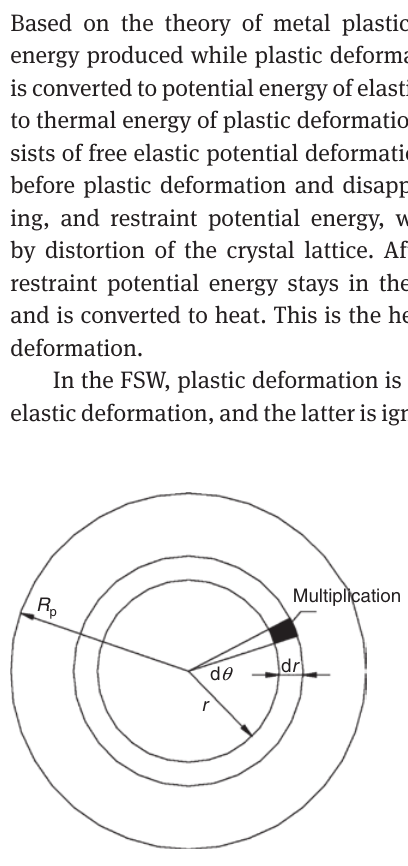
Figure 6: The multiplication model on the bottom area of the pin.